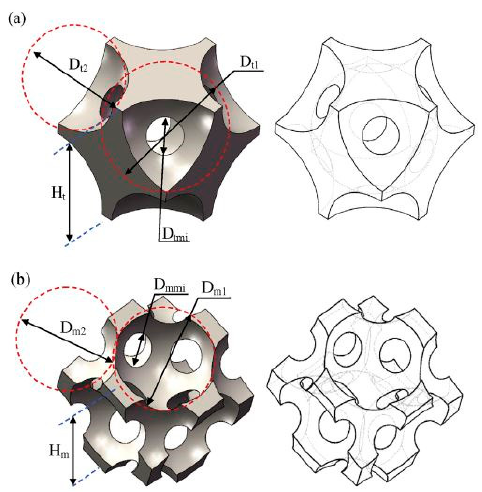
Figure 19. A cell of the designed porous structure with two different crystal structures, Body Centered Cubic (BCC) and Face Centered Cubic (FCC). For the porous cell of BCC H t represents the edge length of the cube structure model, as shown in ( a ). Moreover, D t1 indicates the diameter of the atom at the center of the BCCS. D t2 represents the diameter of eight atoms at the apex angle. D tmi indicates the diameter of the interconnected hole. Furthermore, for the porous cell of FCCs, H m represents the edge length of the cube structure model, as shown in ( b ). D m1 indicates the diameter of atoms in the center of the FCCs. D m2 represents the diameter of eight atoms at the apex angle. D mmi indicates the diameter of the interconnected hole [181]. Reproduced with permission from [181]. Copyright Elsevier, 2020.